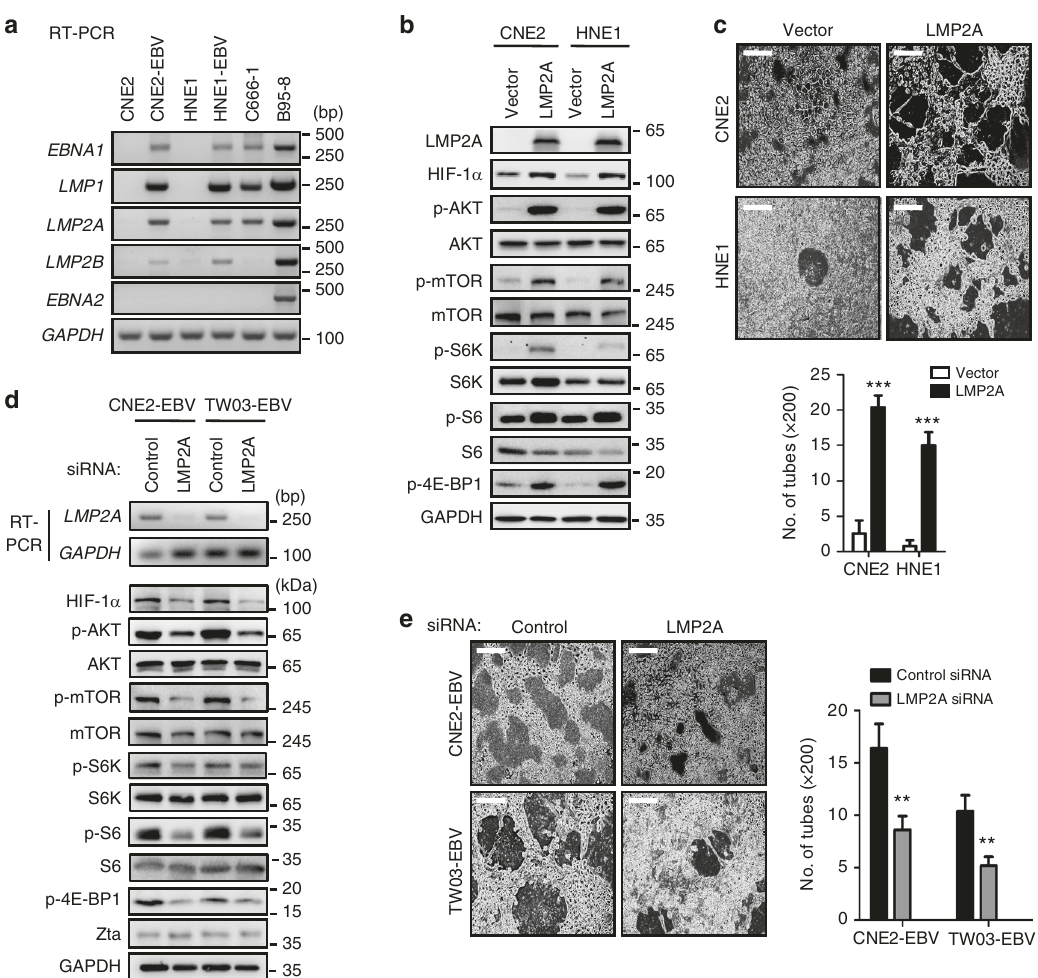
Fig. 6 LMP2A is involved in VM formation and AKT/HIF-1 α activation. a RT-PCR analysis of EBV latent genes in CNE2 and HNE1 cells carrying recombinant EBV (Akata strain) and the native EBV-infected cell line C666-1. GAPDH was used as the internal control. b CNE2 and HNE1 cells were transfected with empty vector or construct encoding LMP2A. Activation of AKT/mTOR/HIF-1 α signaling pathway was determined by immunoblotting. c Representative images (top) and quanti fi cation (bottom) of tube formation on Matrigel of control and LMP2A-overexpressing NPC cells. Scale bars = 100 μ m. Tube numbers were counted under a microscope with 200× magni fi cation in randomly chosen fi elds. Mean± SD, n = 5, two-tailed Mann – Whitney test. d CNE2- EBV and TW03-EBV cells were transfected with control or LMP2A-speci fi c siRNAs. The knockdown ef fi ciency was determined by RT-PCR, and HIF-1 α level and AKT/mTOR/S6K signaling activity were determined by immunoblotting. e Representative images (left) and quanti fi cation (right) of tube formation of NPC-EBV cells transfected with control or LMP2A-speci fi c siRNA. Scale bars = 100 μ m. Mean ± SD, n = 5, two-tailed Mann – Whitney test. ** p < 0.01 and *** p <